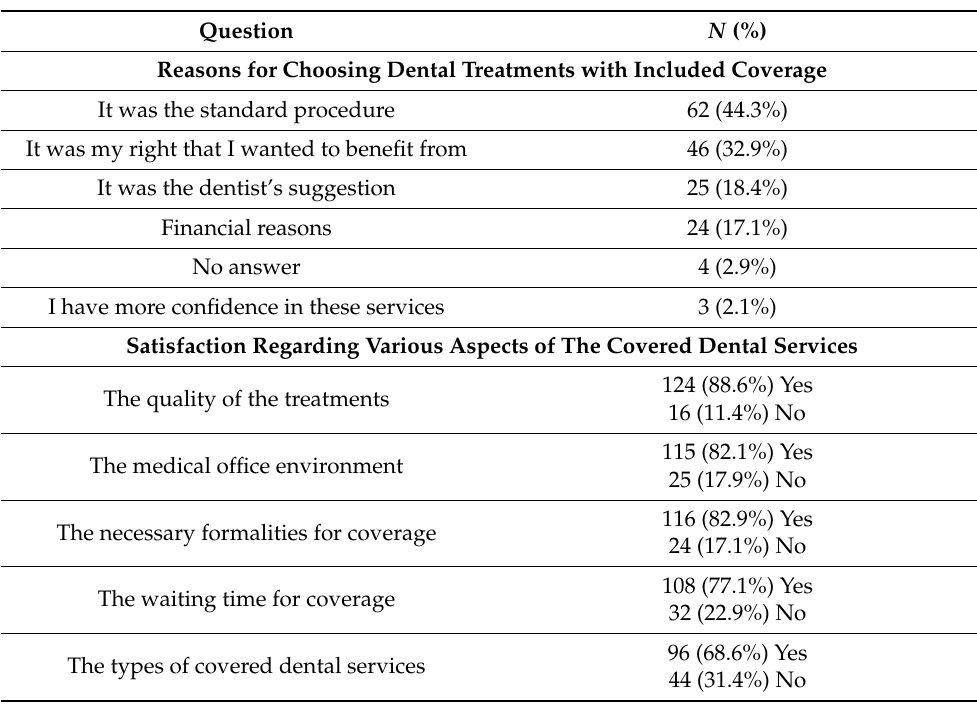
Table 4. Patients’ attitude regarding previous dental treatments using public health